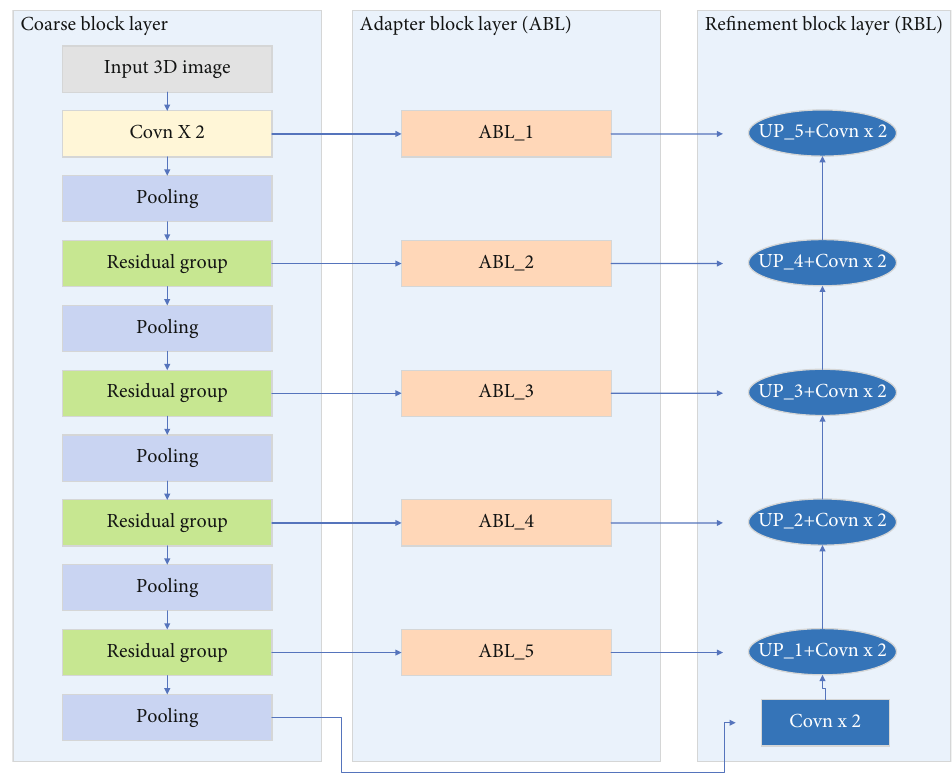
Figure 2: The traditional 3D convolution